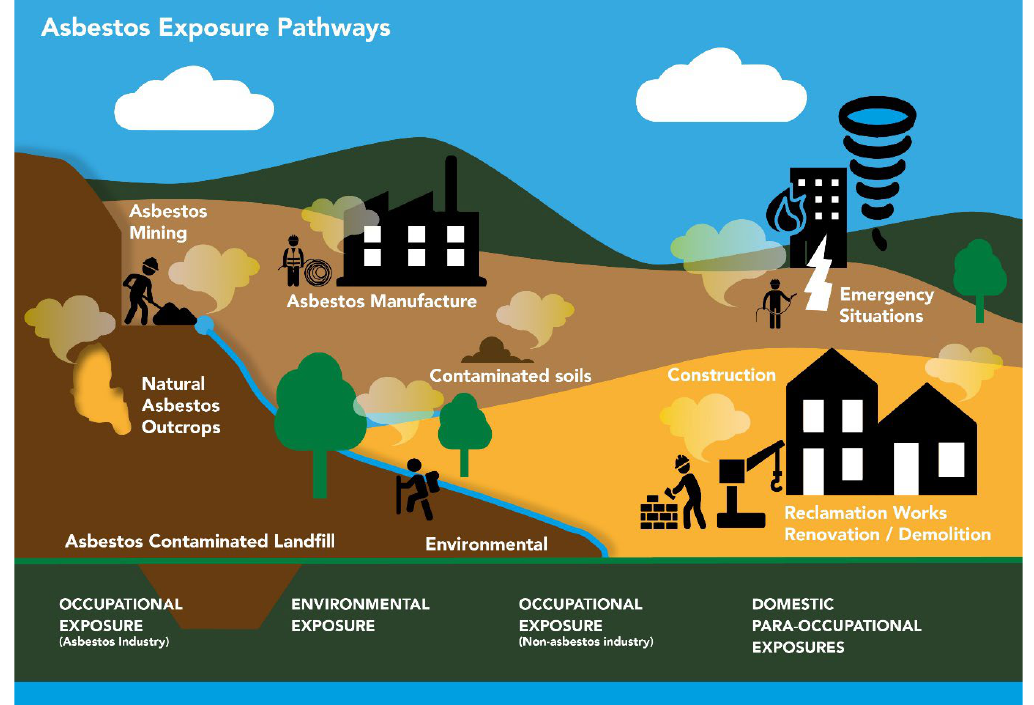
Figure 3. A summary of potential exposure pathways for asbestos exposure globally.